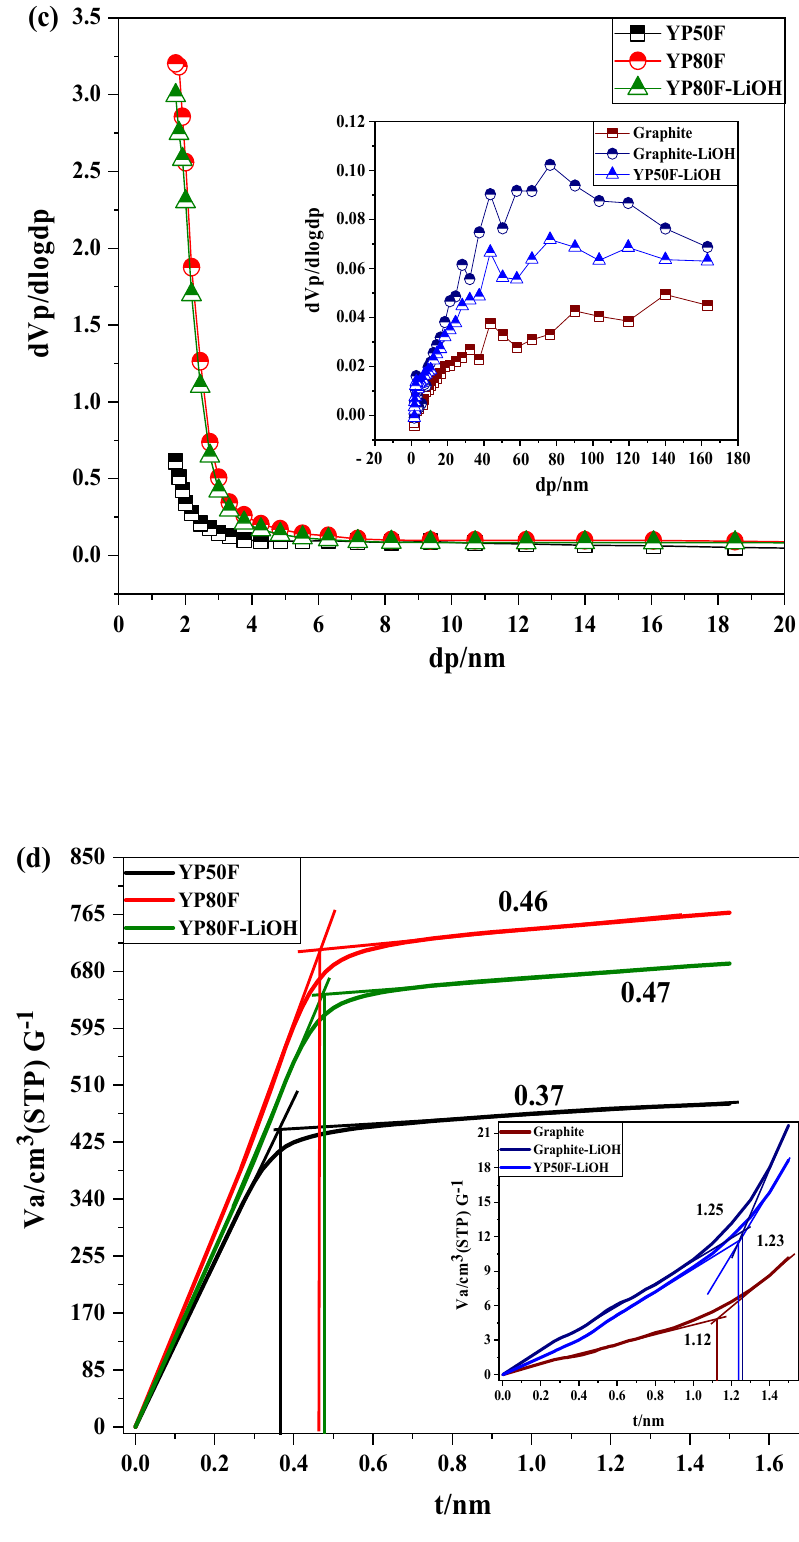
Figure 6. ( a ) Nitrogen adsorption–desorption isotherms, ( b ) NLDFT/GCMC Pore size distribution analysis, ( c ) BJH plot and ( d ) T-curve of graphite, YP50F, YP80F and LiOH-treated carbon materi- als. Table 2. Nitrogen adsorption–desorption isotherms of bare graphite, YP50F, YP80F and Li- OH-treated samples.